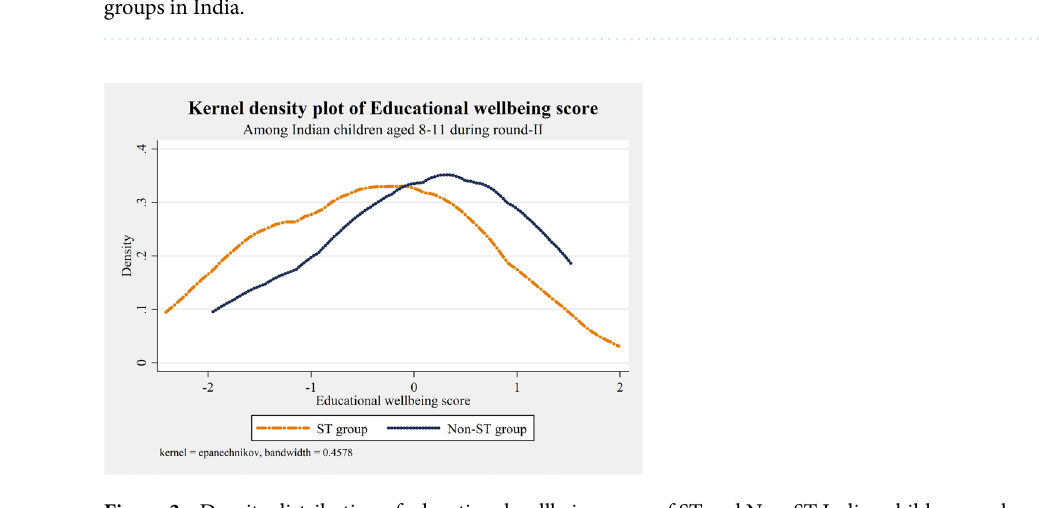
Figure 3. Density distribution of educational wellbeing score of ST and Non-ST Indian children aged 8–11 years during IHDS